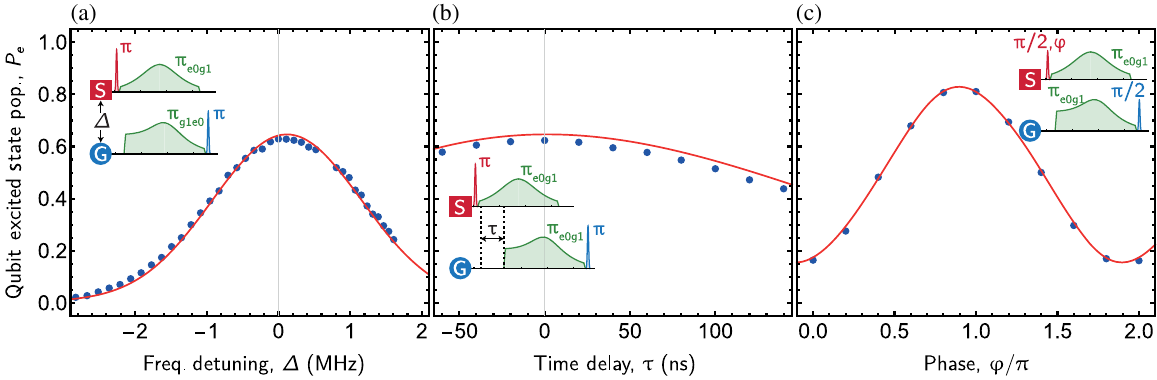
FIG. 12. Measured (blue dots) and simulated (red line) excited state population P inset shows the envelopes of the pulse sequence applied to the gate chip ( G , blue circle) and the source chip ( S , red rectangle) during the respective calibration steps. (a) Measured excited state population P and absorbing it at the gate qubit vs frequency detuning Δ between the converter modes of the source and gate qubit. Photons are emitted or absorbed in resonance with the respective converter mode. (b) Excited state population P delay found in the experiment) between the emission pulse at the source qubit and the absorption pulse at the gate qubit. (c) Excited state population P , when emitting and absorbing a photonic superposition state ðj 0 i þ e i φ j 1 iÞ = e rotation along the Y axis to the gate qubit.